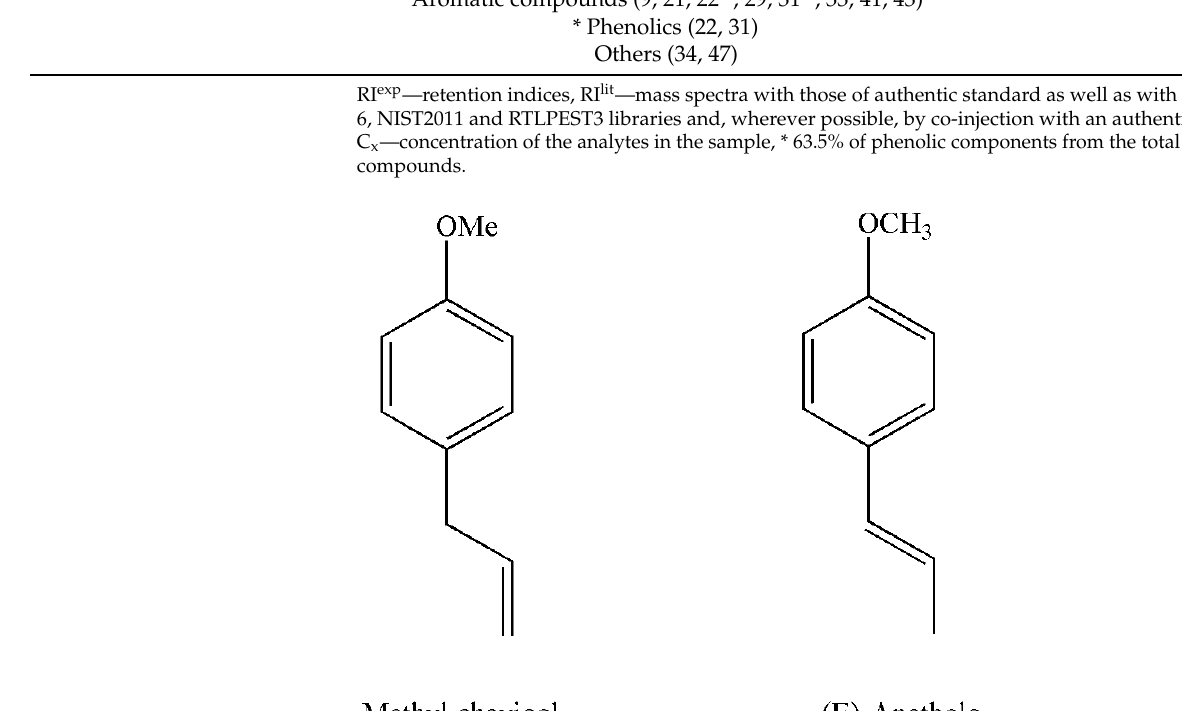
Figure 4. GC/FID chromatogram of essential oil isolated from wild fennel leaves. Furthermore, p -Cymene (6.5%), α -phellandrene (5.9%), β -phellandrene (4.9%), and fenchone (3.2%) are components that are somewhat less represented. The components of essential oils in fennel leaves that are present in the range of 1% to 2% are α -thujene (1.9%), trans-piperitone epoxide (1.8%), δ -3-carene (1.7%), hexadecanoic acid (1,7%), γ -terpinene (1.4%), myrcene (1.3%), methyl o-anisate (1.3%), α -phellandrene epoxide (1.2%) and cis- piperitone epoxide (1.2%).The content of all other components is below 1%, withsome of them only in traces (Table 3). Table 3. Chemical composition of essential oils isolated from wild fennel leaves. N°